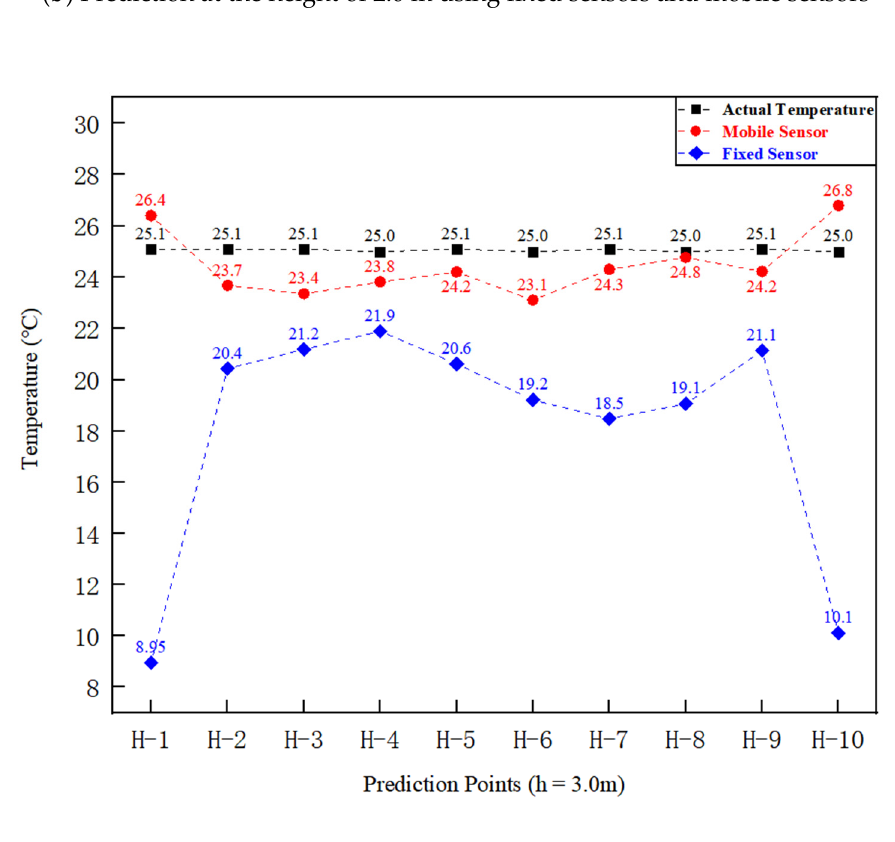
Figure 9. Prediction of different heights using fixed sensors and mobile sensors.